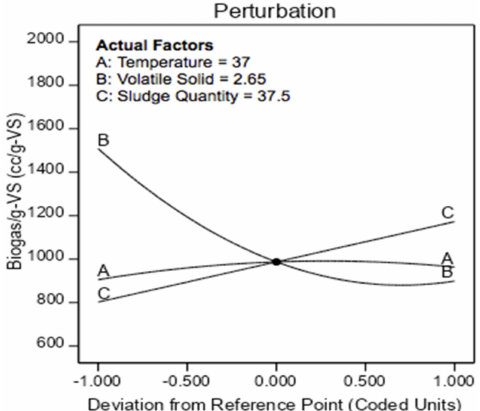
Figure 8. Perturbation plot illustrates the effect of all factors on